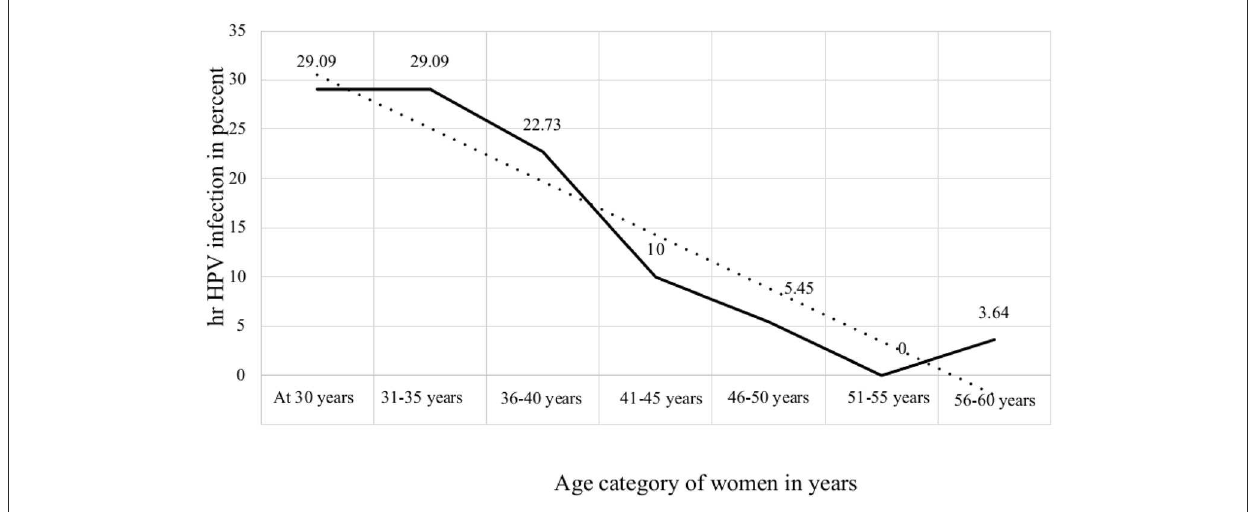
FIGURE4 Age-specific prevalence of hr HPV infection among women in